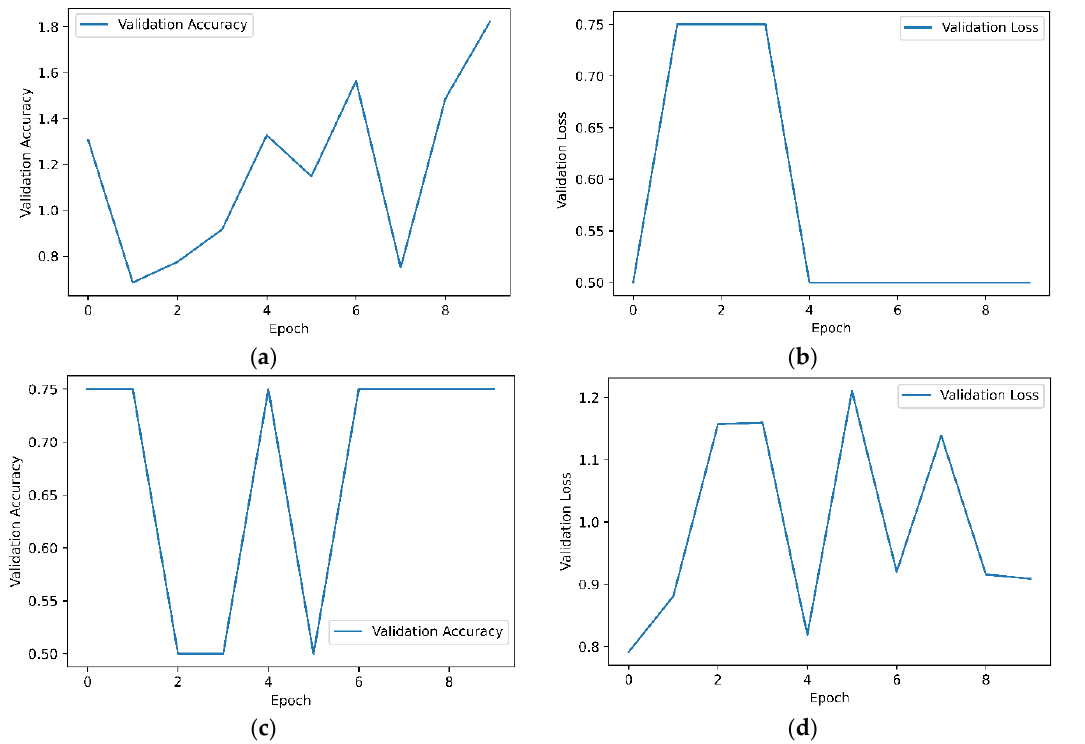
Figure 6. Model accuracy and loss of Conv2D models during cross validation. ( a ) Model accuracy of Xception; ( b ) model loss of Xception; ( c ) model accuracy of VGG19; ( d ) model loss of VGG19.